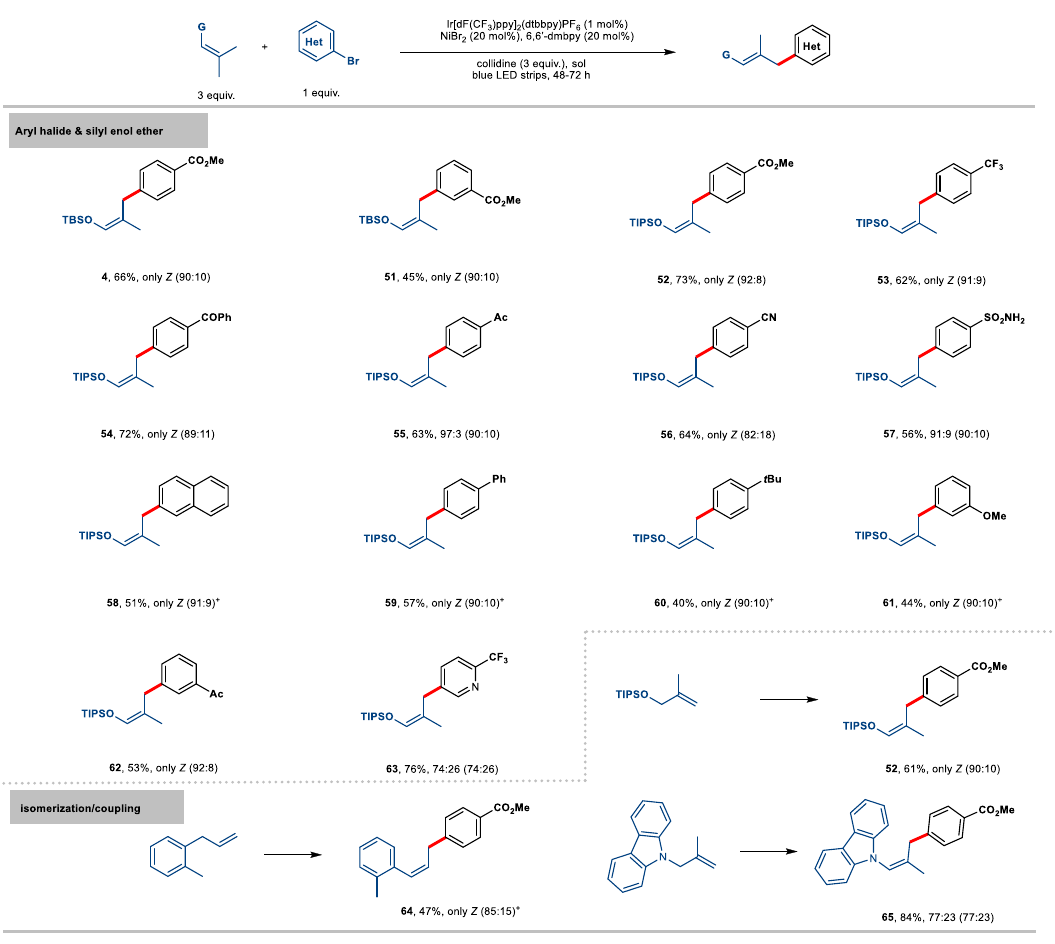
Fig.4|Scopefortheformationof Z isomerwitharylhalidesandisomerization/ cross-coupling. Unless otherwise speci fi ed, the reactions were performed on a 0.2mmol scale under the following reaction conditions: alkene (3 equiv.), aryl halide(1equiv.),2,4,6-collidine(3or1.5equiv.), PC-1 (1mol%),NiBr 2 (20mol%),6,6 ’ -